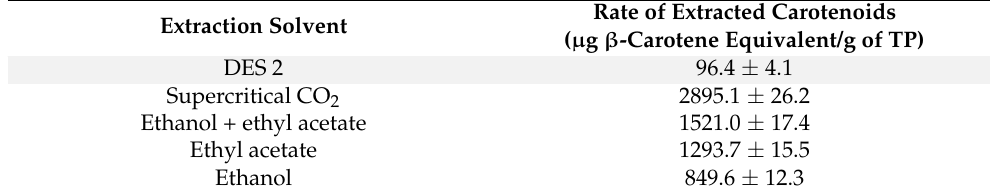
Table 7. Comparison of extracted carotenoid rates from tomato